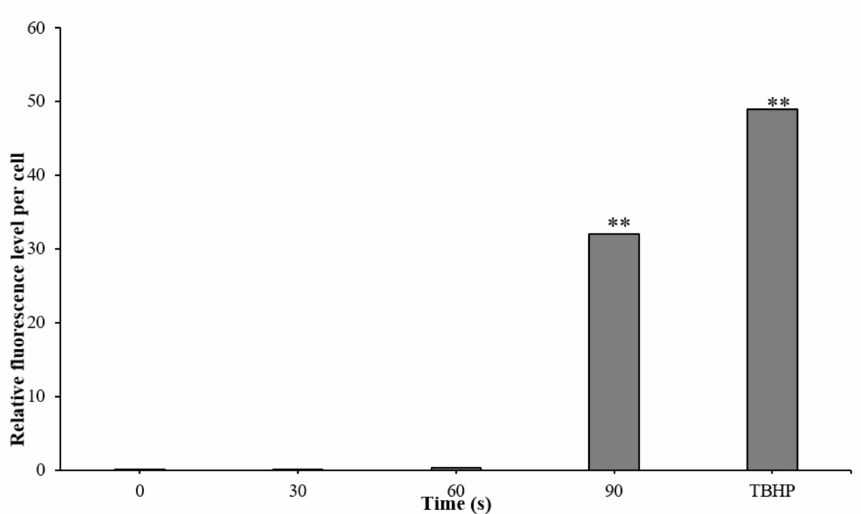
Figure 6. ROS level per A. tumefaciens bacterial cell as a function of plasma corona discharge treatment duration. Bacteria suspension (3 × 10 8 CFU/mL) was treated with plasma for 0, 30, 60, and 90 s. The relative fluorescence level was normalized to the amount of the CFU in the different samples. TBHP served as a positive control. p -value by t -test: ** p < 0.005 presented in three independent experiments of exposure to 30, 60, and 90 s, compared to the non-treated